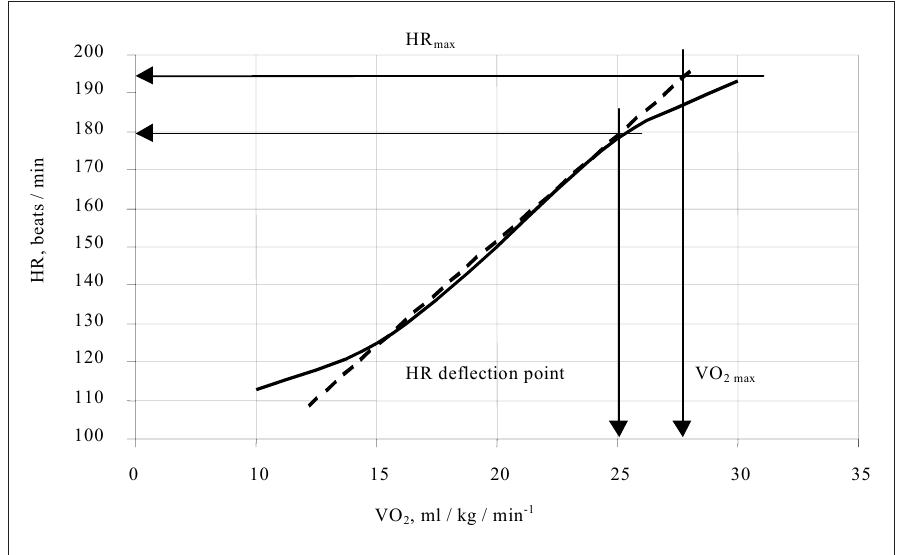
Fig. 1. Relationship of heart rate to running speed in one